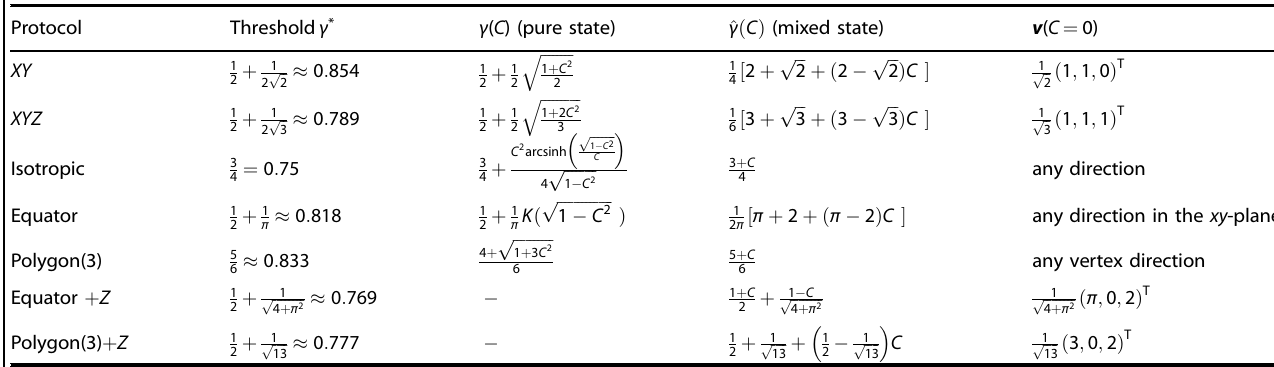
Fig. 3 Relation between the guessing probability γ F ( F B ) and the reduced fi delity F B for various veri fi cation protocols of the Bell state. Here the XY protocol and isotropic protocol are introduced in the main text, while other protocols are proposed in the Supplementary Material. Table 1. Concrete protocols for verifying the Bell state in an untrusted quantum